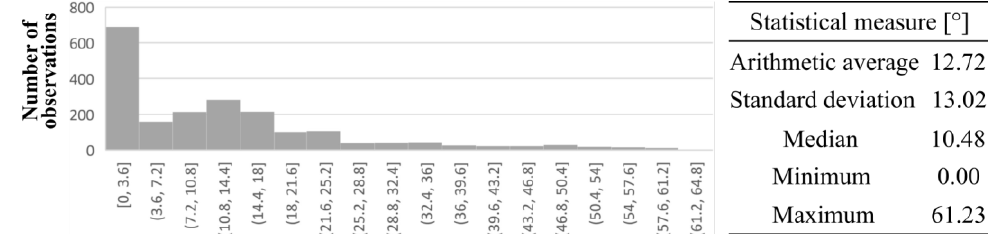
Figure 10. The course determination error by the satellite compass m HDG [°].